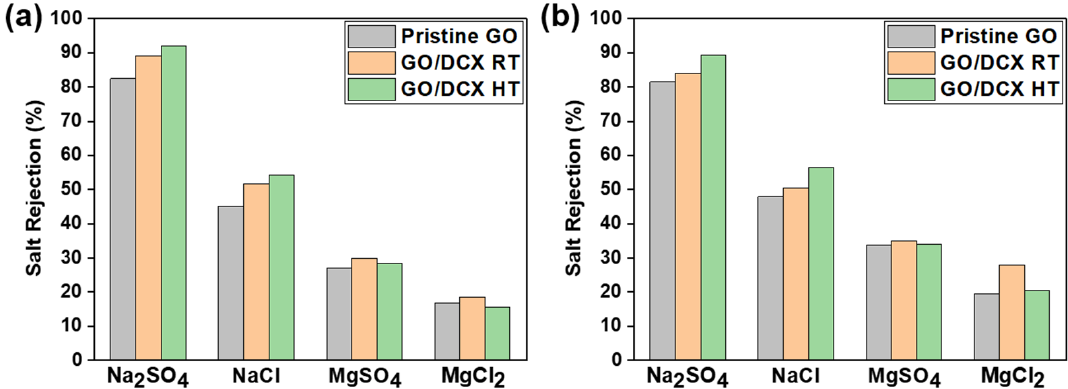
Figure 9. Salt rejection rates (Na 2 SO 4 , MgSO 4 , NaCl, and MgCl 2 ) of the GO membranes at ( a ) 3 bar and ( b ) 5 bar.